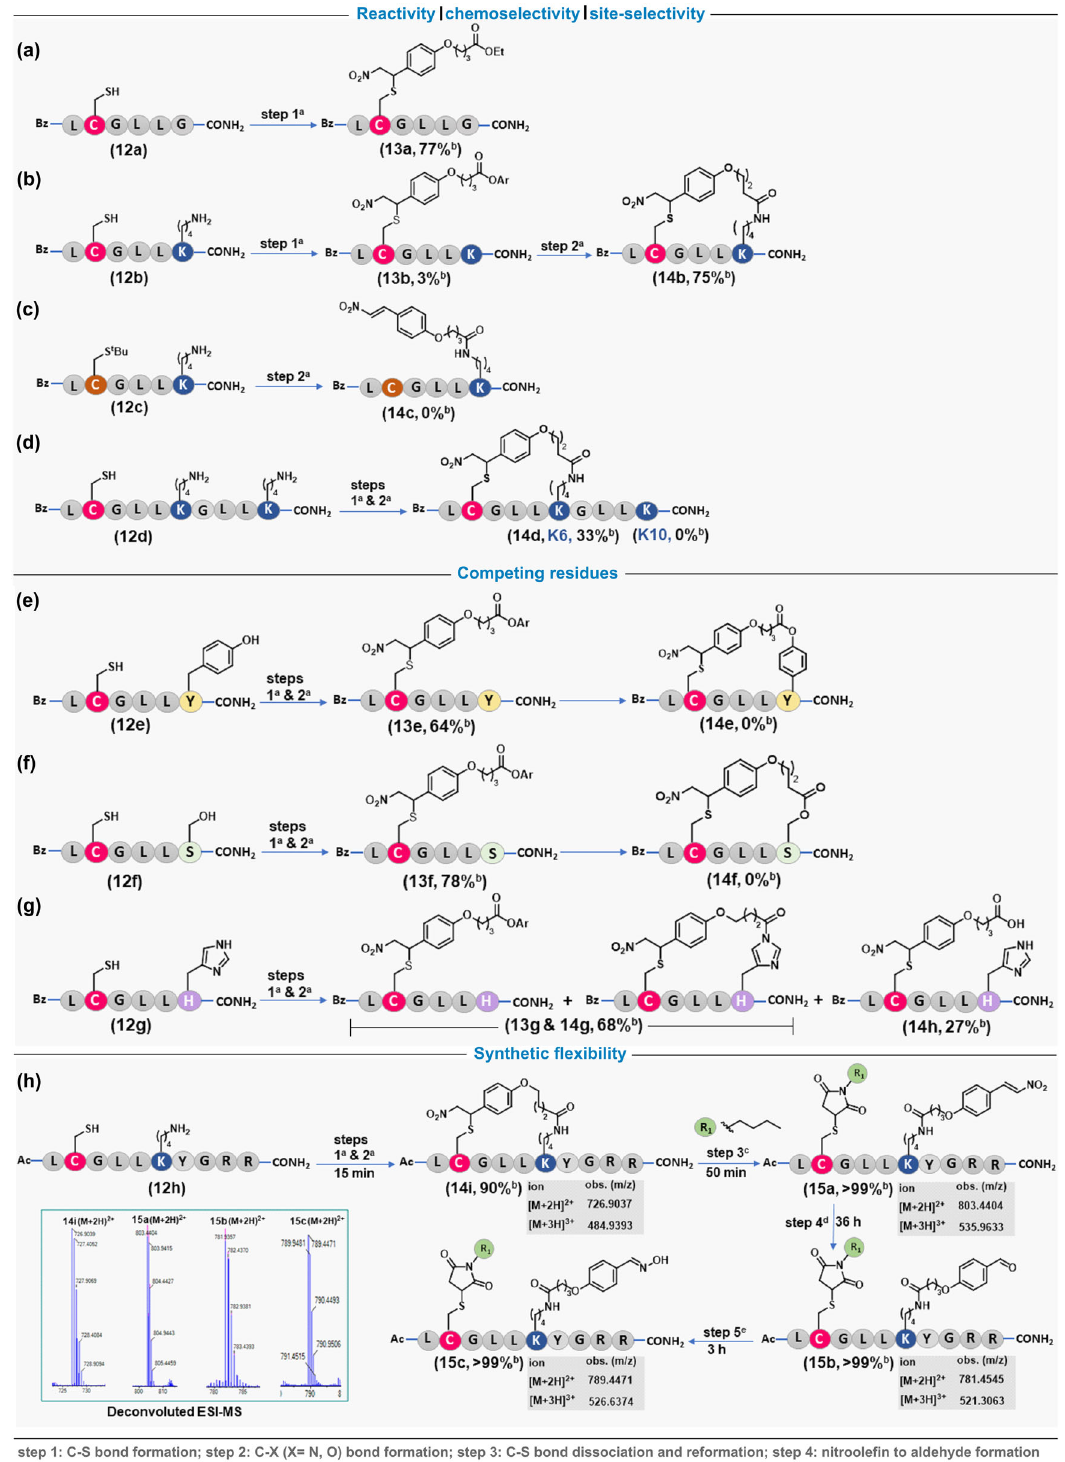
Fig. 4 | Peptide modi fi cation. a Control reagent 1l with F C and Cys-containing peptide 12a resultsinef fi cientC-Sbondformation. b LDM C-K reagent 9d mixedwith peptide 12b havingCysandLysat i and i + 4 positionsresultinC-Sbondfollowedby C-N bond formation rendering the cyclic peptide 14b within 1h. c LDM C-K reagent 9d withpeptide 12c havingthiolprotectedCysandLysat i and i + 4 positionsresult in no conversion within 1h. d LDM C-K reagent 9d with peptide 12d having Cys at i